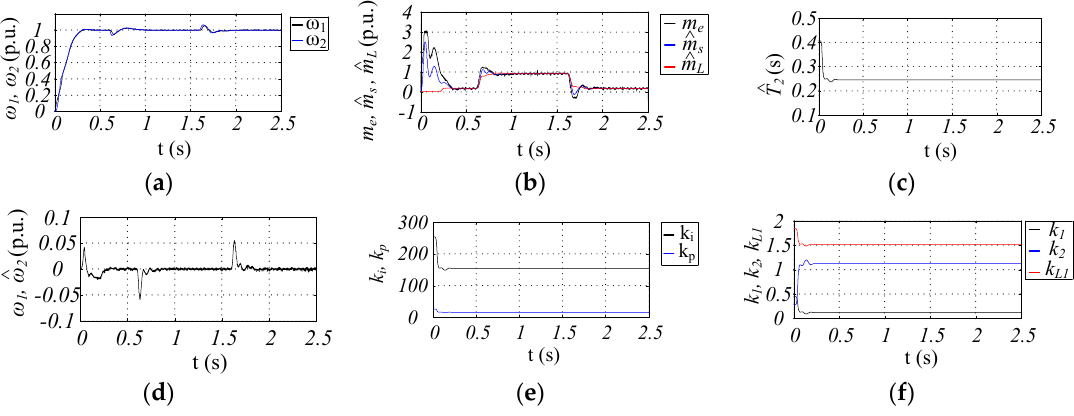
Table 4. Values of the estimation errors and their derivatives for the UKF and FUKF – experimental study.